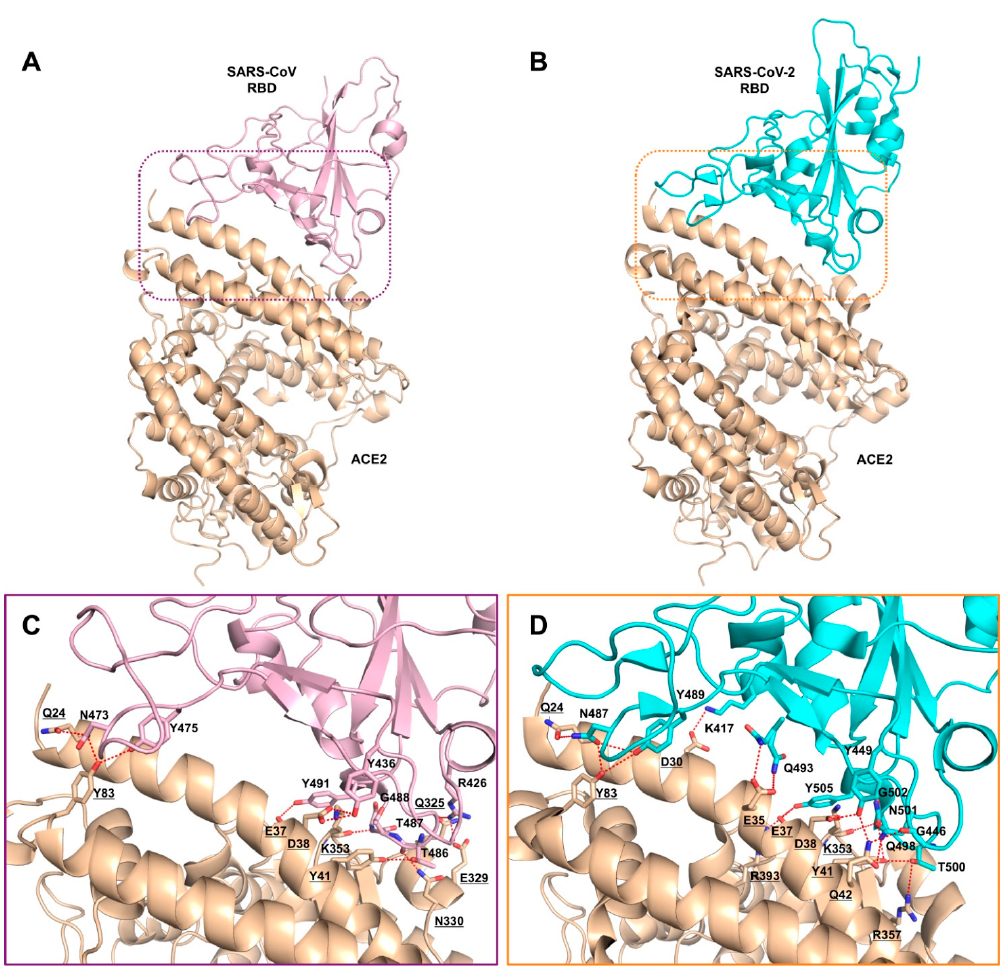
Figure 4. Comparisons of the interactions formed at the interfaces between SARS-CoV and SARS-CoV-2 RBDs and ACE2. Overall structure of ( A ) SARS-CoV (light pink, PDB ID: 2AJF) and ( B ) SARS-CoV-2 (cyan, PDB ID: 6M0J) RBDs bound to ACE2 (wheat). Key residues involved in SARS-CoV RBD/ACE2 ( C ) and SARS-CoV-2/ACE2 ( D ) complex formation are shown as sticks and labeled. ACE2 residues are underlined for clarity. Hydrogen bonds and salt bridges are displayed as dashed red lines.